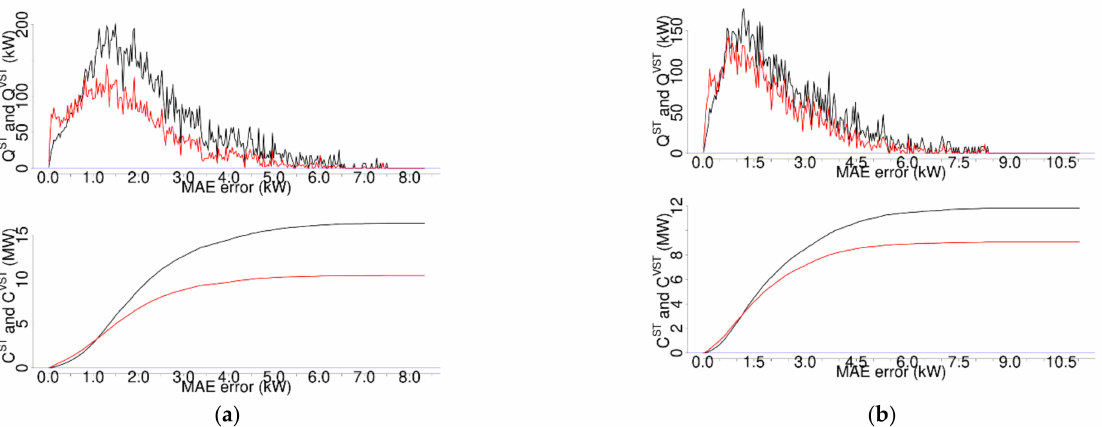
(cid:0) (cid:1) Figure 10. Total run time errors Q ST ε ST r in black and Q VST (cid:1) (cid:1) (cid:0) (cid:0) C ST ε ST r ε ST r and C VST in the bottom as a function of the ST error ε ST r . ( a ) P1 with forecast horizon K = 60 min, ( b ) P4 with forecast horizon K = 90 min (see Equation (17) and Equation (18) in Section 2.4 for details of the